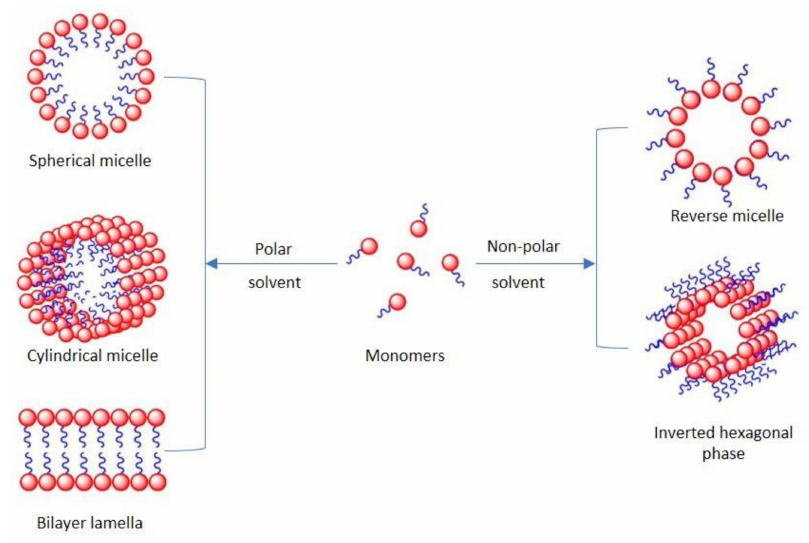
Figure 1. Surfactant molecular